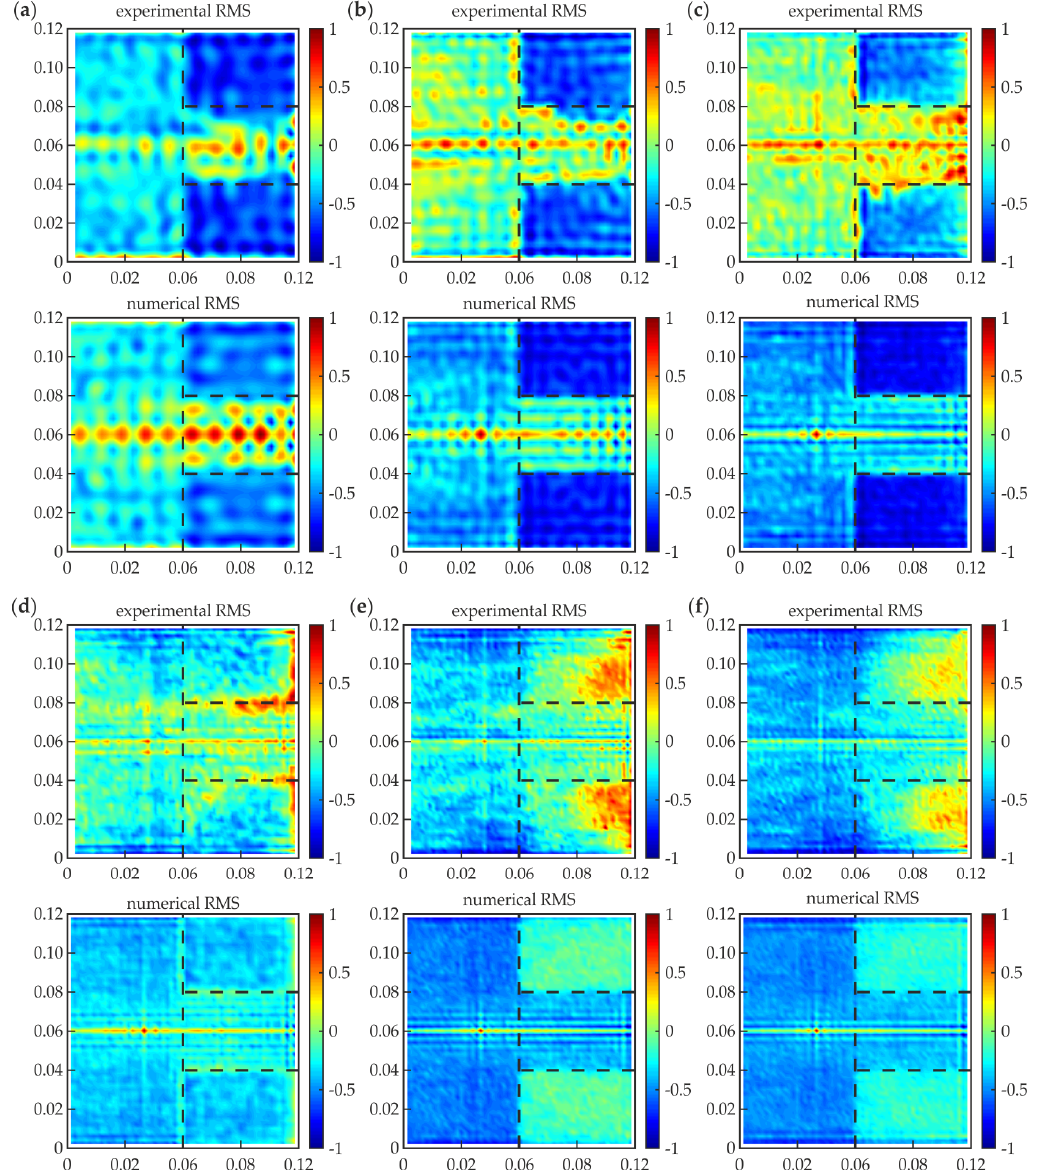
Figure 9. Experimental and numerical root mean square (RMS) maps for different excitation frequencies: ( a ) f = 50 kHz; ( b ) f = 100 kHz; ( c ) f = 150 kHz; ( d ) f = 210 kHz; ( e ) f = 300 kHz; and ( f ) f = 350 kHz.